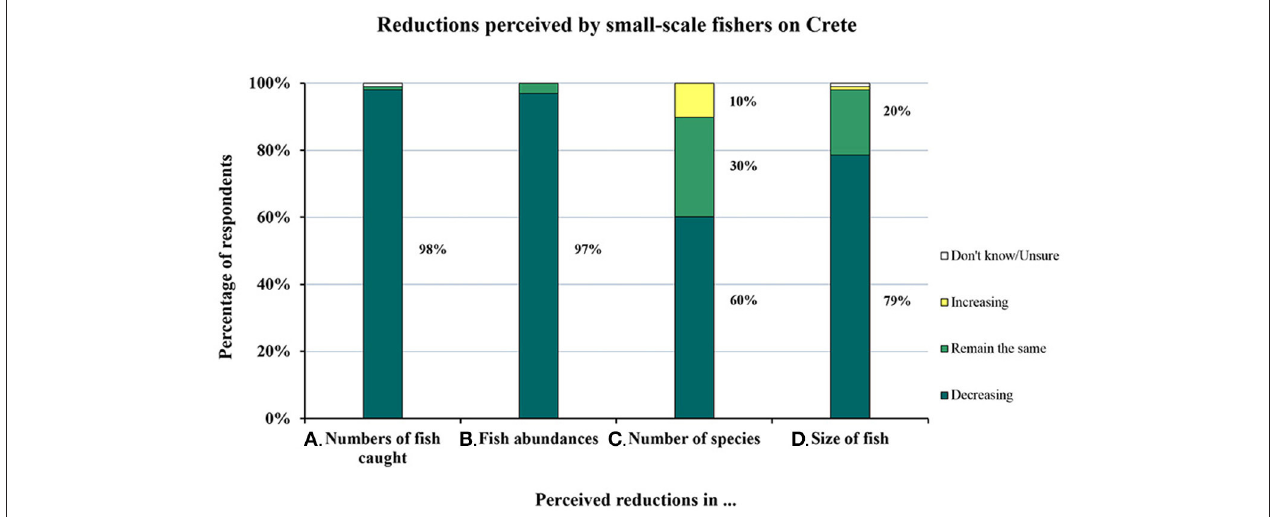
FIGURE 2 | Reductions in catch as perceived by small-scale fishermen on Crete: perceived reductions in: Numbers of fish caught, fish abundances in general, numbers of species and size of fish caught. Fishermen observed reductions in numbers of fish caught and in fish abundances in general.